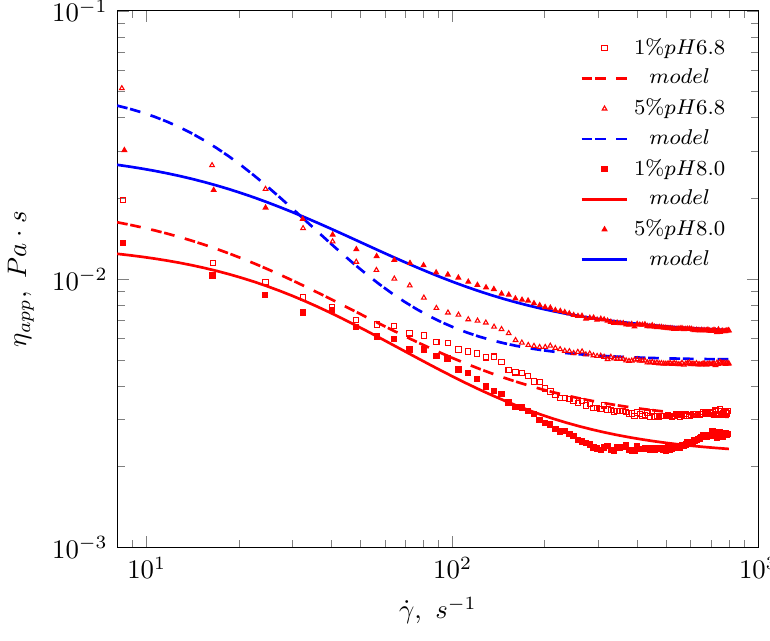
Figure 5. Flow curves and fitted Cross model Equation (11) of selected emulsions. The higher viscosity of the continuous phase has a positive effect on the stabilization of the O/W emulsion. Moreover, the higher concentration of the fava bean protein isolate enhanced the stability of the interface in the oil-water system due to the high concentration of hydrophobic elements of the protein chains. The effects differ based on the concentration of the protein isolate with the rheological behavior and are reflected in the values of the parameters in the Cross rheological models (Table 3) during the continuous phase of pH 6.8, as well as 8.0. In the case of the Cross model, it can be noticed that the increase in the concentration of the isolate generates higher values of the viscosity η 0 and η ∞ . The values of the K time constant from the Cross model confirmed the increase in emulsion stability with the concentration of the isolate. The values of this constant can be interpreted as the relaxation time which, in the case of an emulsion, can indicate creaming and thus a tendency towards spontaneous delamination. In the case of pH 5.0, the values of η 0 and η ∞ decrease with increasing concentration of the protein isolate. In the case of an emulsion made from a 5% isolate solution, the constant K has the highest value. The time constant ( K ) is related to emulsion instability (creaming). Thus, emulsions showing longer times showed greater stability due to strong drop-drop interactions, which can also be observed in Reference